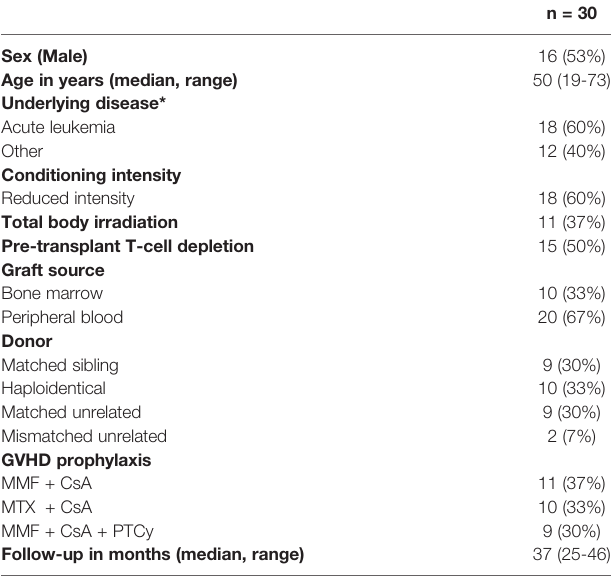
TABLE 1 | Clinical characteristics of study